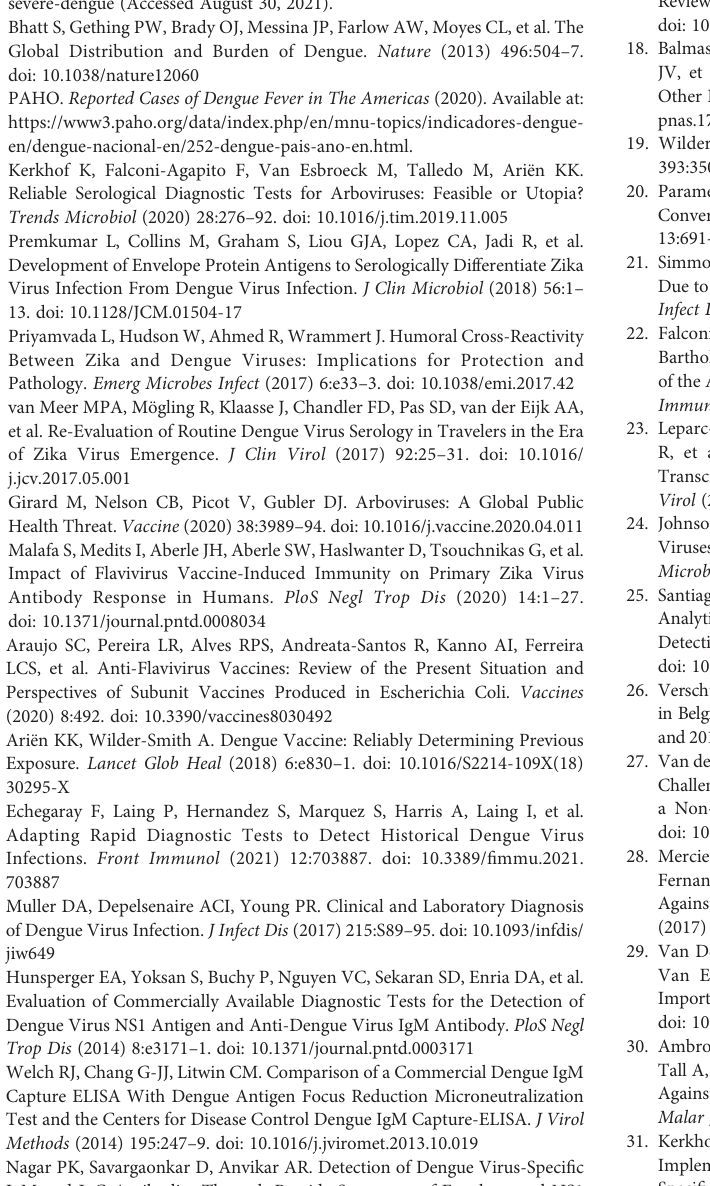
Supplementary Figure 6 | Comparison of result outcomes between the random forest models and DENV commercial diagnostic kits. The analysis was performed in a subset of 41 endemic DENV positive samples. (A) Cell plot where each column represents a serologic test and each row represents a sample. The analysis for the DENV peptides was done with the combination of peptides based on the random forest analysis. (B) Peptide composition of each model for IgM peptides (RFM) and IgG peptides (RFG). (C) Differences in classi fi cation were assessed by pairwise comparison using Cohen ’ s kappa and McNemar ’ s test. The values above the diagonal indicates the kappa coef fi cient with the 95% CI range for the Cohen ’ s test while for the MacNemar ’ s test they represent the Odds ratio. The values below the diagonal in each table corresponds to the p